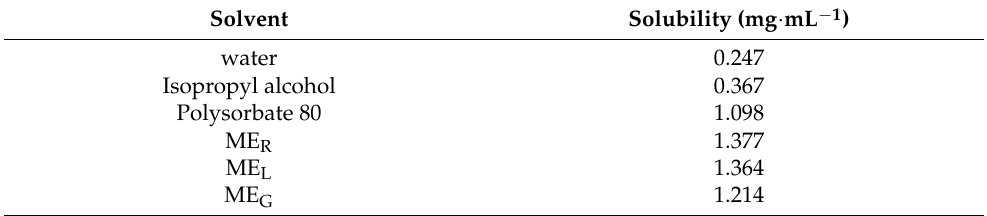
Table 3. The Comparison of Minoxidil (MXD) Solubility Equilibrium in the Solvents and the Mi-